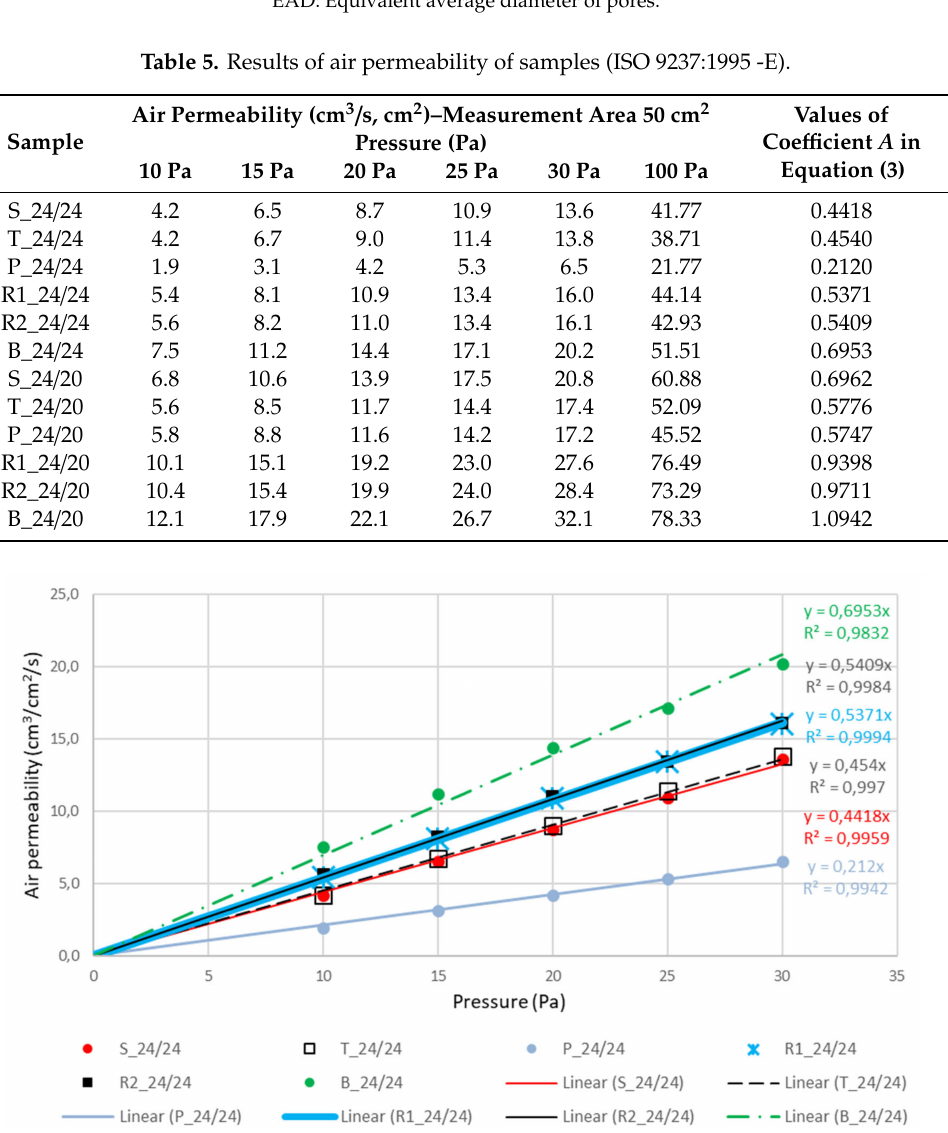
Figure 5. Linear regression of curves air permeability—pressure for the samples in densities 24 /